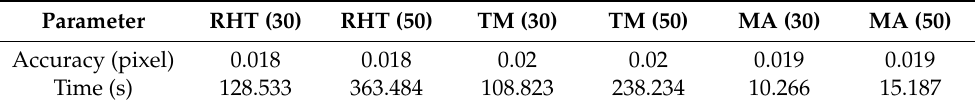
Table 1. Comparison of accuracy and consumed time for the three methods with the extended range n of 30 pixels and 50 pixels.